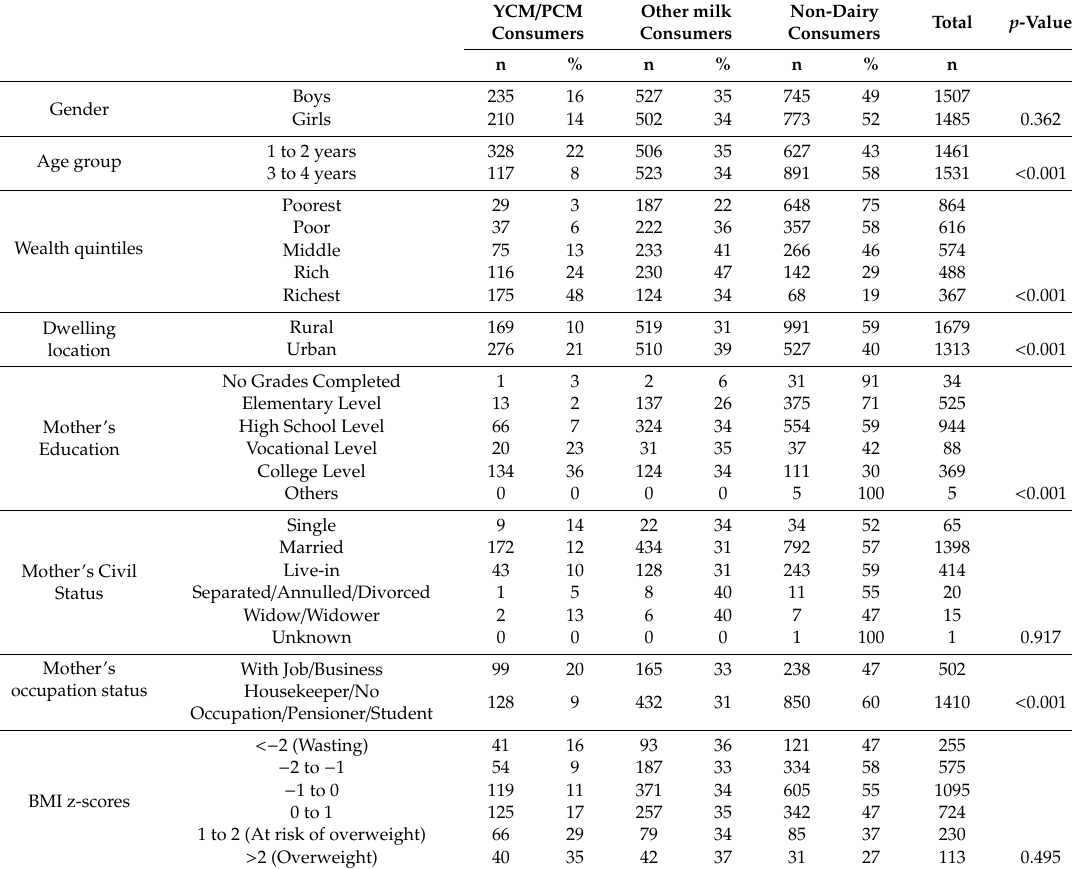
Table 1. Sample characteristics by consumer group (toddlers and young children aged one to four